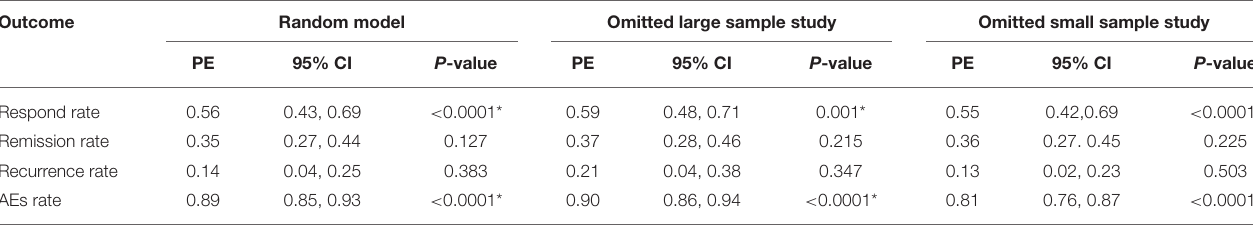
TABLE 4 | Results of the sensitivity analysis (open-label studies).